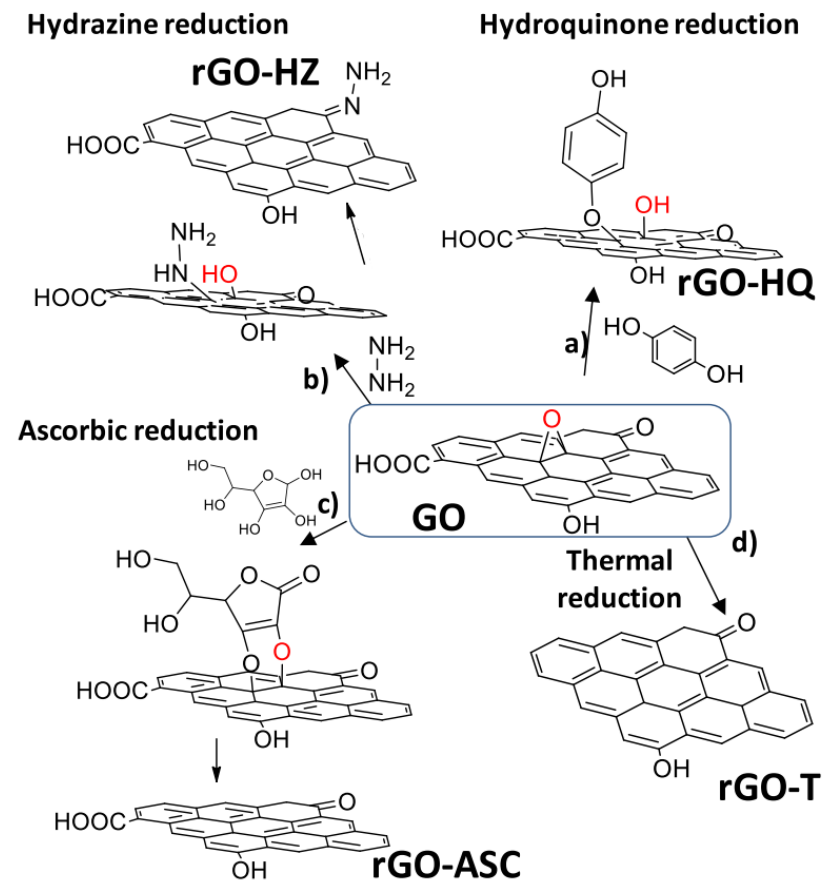
Figure 8. Variation of the nature of functional groups in reduced graphene ‐ oxide (rGO) depending on the reduction treatment: ( a ) hydroquinone, ( b ) hydrazine, ( c ) ascorbic acid as reducing agents, or ( d ) by thermal reduction. Reprinted with permission from reference [131].